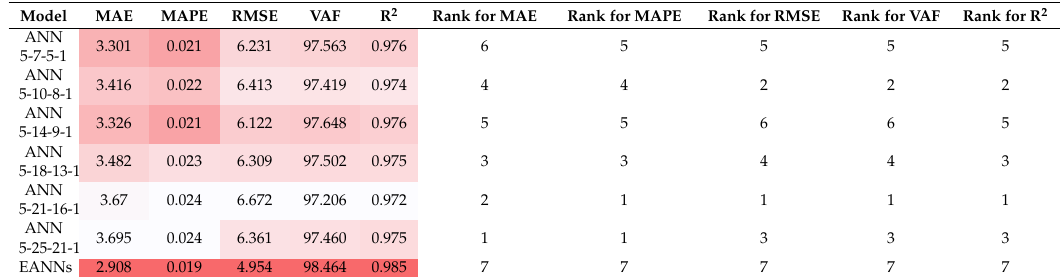
Table 2. Statistical indexes of the models for a set of data in the training.